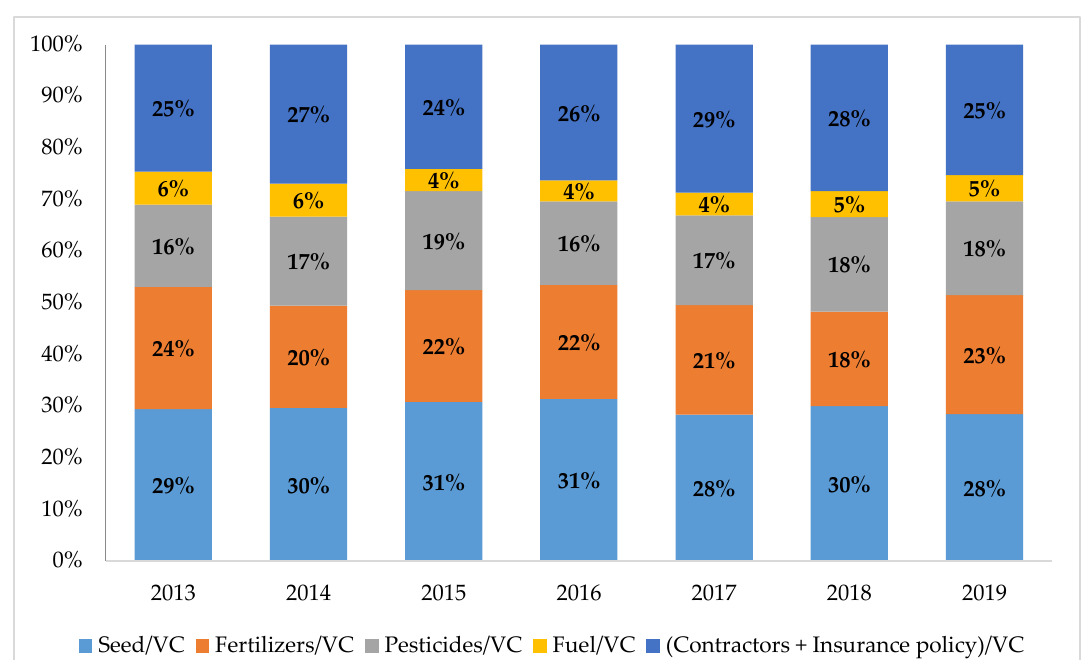
Figure 3. Incidence of the single variable cost categories as parts of the total variable costs.